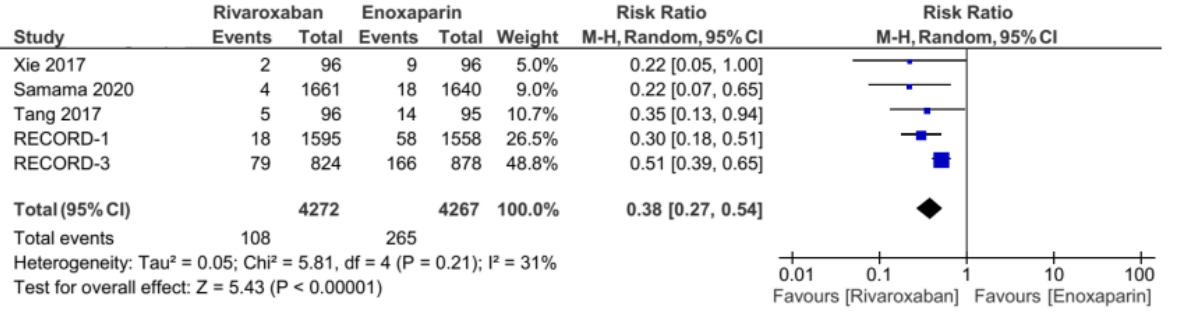
Figure 3. Incidence of distal DVT [5,7,13,14]. Figure 4. Incidence of proximal DVT [5,7,13,14].